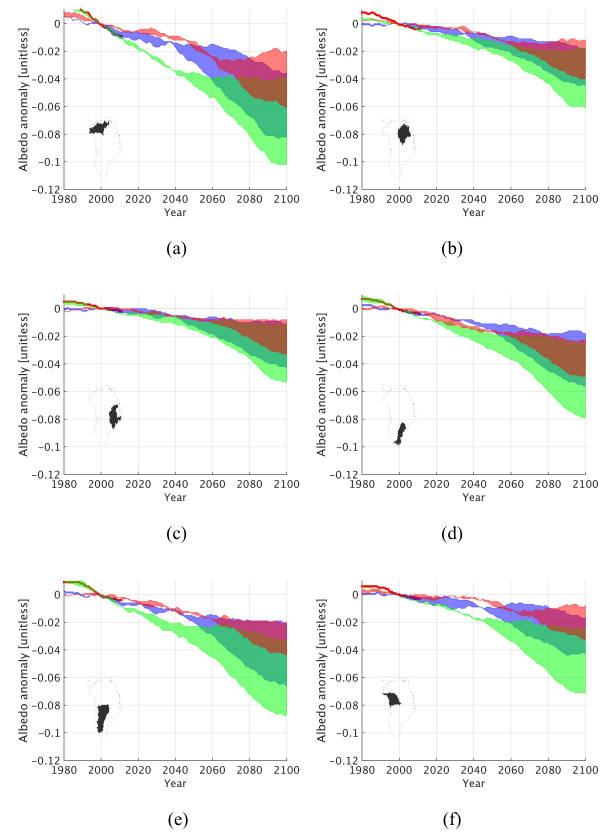
Figure 12. Same as Fig. 11 but for different drainage regions of the GrIS, indicated by the small maps in each panel. The colour scheme for the shaded regions is the same as Fig. 10. The top and the bot- tom of each area plots represent the results concerning the RCP45 (bottom panels) and RCP85 (top panels) scenarios. Red lines repre- sent the GLASS albedo averaged over the corresponding drainage